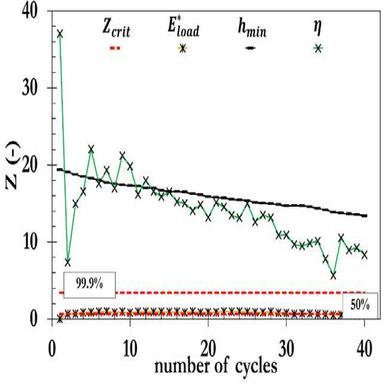
Evolution with cycles of the parameter Z for the comparison between neat polymer and composite surface mean values of instantaneous elastic modulus (\), residual depth (-) and energy ratio (×) and of Zcrit for an interval of confidence of 99.9% (upper dashed red line) and 50% (lower dashed red line).